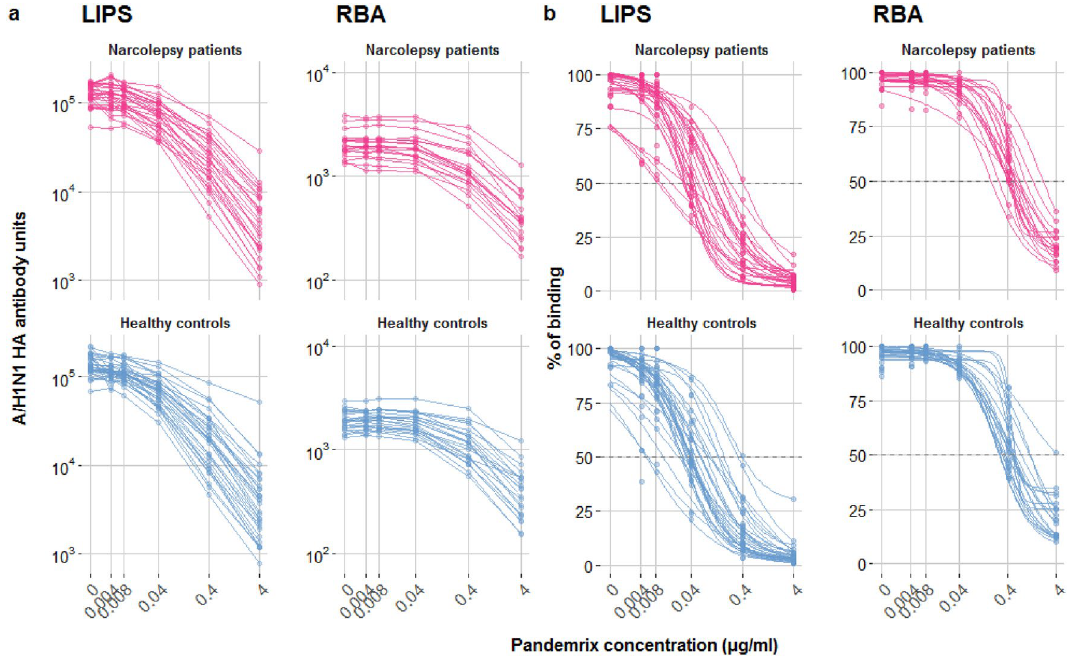
Figure 2. Displacement analysis of A/H1N1 HA antibodies binding in a subset of subjects from the exploratory cohort. Antibody binding was measured in the presence of increasing concentrations of Pandemrix vaccine both in LIPS (patients n = 28, controls n = 32) and in RBA (patients n = 19, controls n = 22). ( a ) Non-normalized displacement curves, showing HA antibody raw measurements (AU and cpm) with increasing competition. ( b ) Fitted curves, determined by a fitted four-parameter log-logistic function (R-package drc) on measured percentage of binding, indicated by coloured